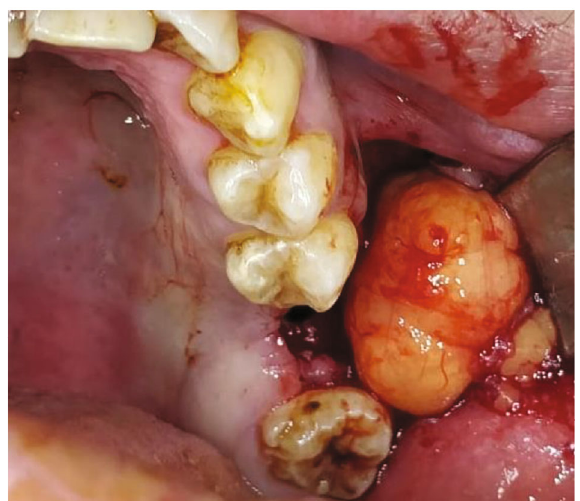
Figure 7: Intraoral view showing access to the buccal fat pad in treating a left maxillary OAC.